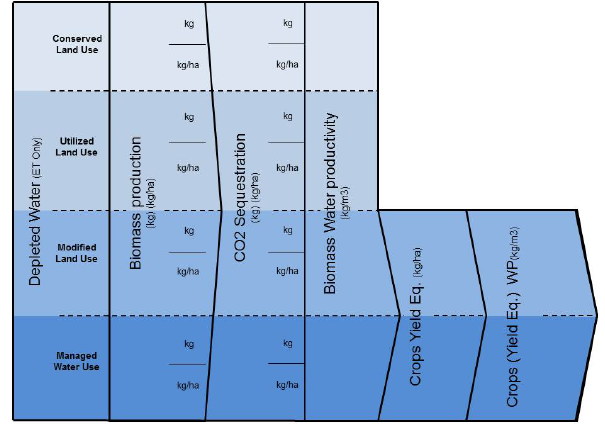
Fig. 4. The WA + productivity